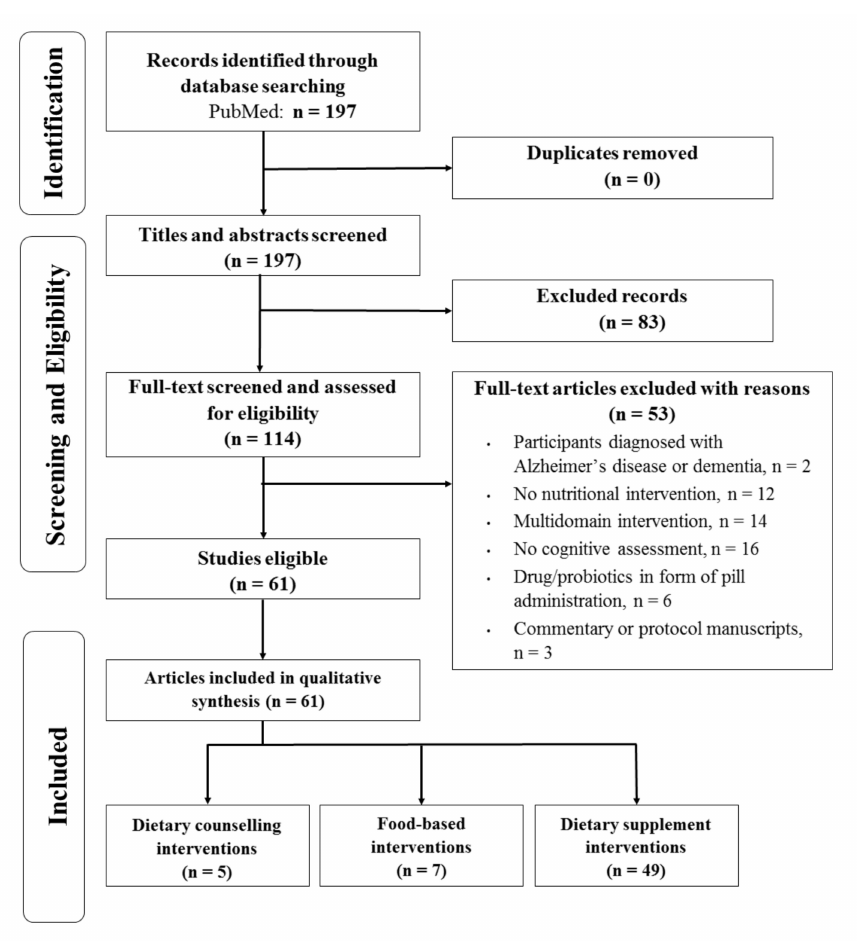
Figure 1. Flow diagram of studies assessed for eligibility per screening